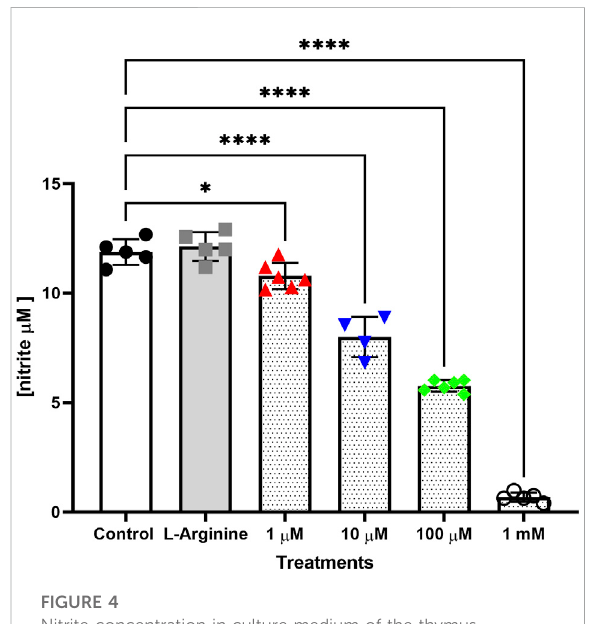
Nitrite concentration in culture medium of the thymus- derived endothelial cell line tEnd.1 after treatment with L-arginine (100 µM) and L-NAME (1, 10, 100 μ M, 1 mM) for 96 h with retreatment every 24 h. Data were compared by Two-way ANOVA, followed by Tukey ’ s test (*Represents statistically signi fi cantdifferencebetweengroupsfor p < 0.05;****Represents signi fi cant difference between groups, for p <